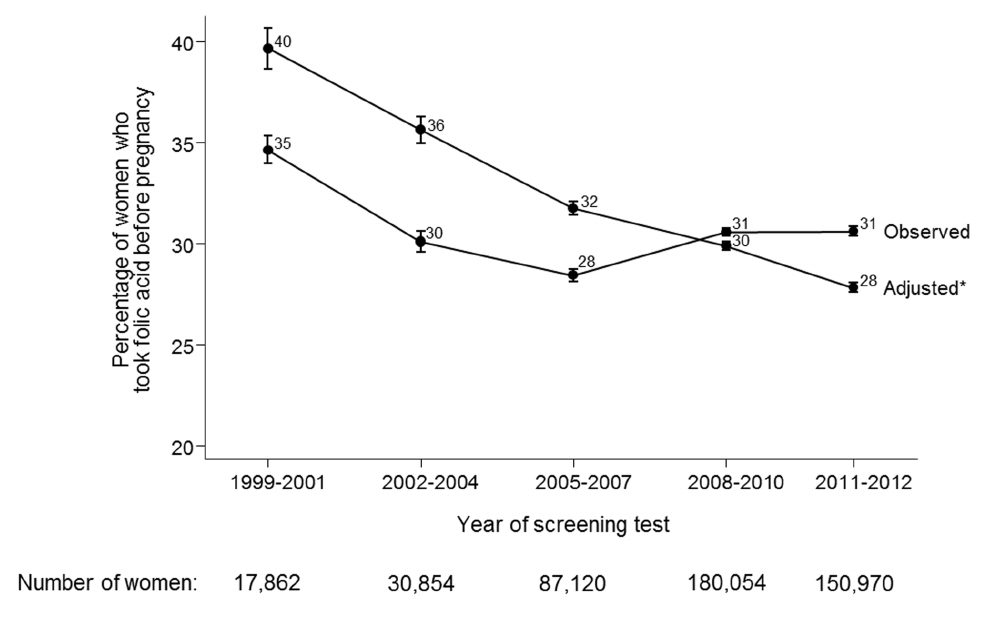
Figure 2. Observed and adjusted* percentage of women taking folic acid supplements before pregnancy according to year.